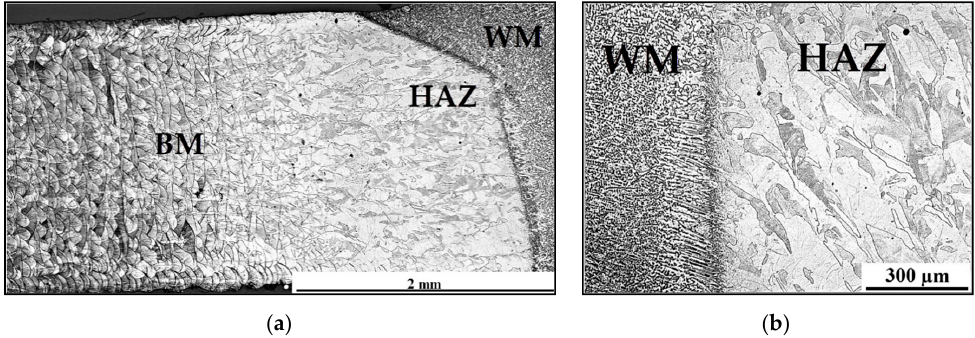
Figure 9. ( a ) Microstructure of the base metal; ( b ) Microstructure with process defects.